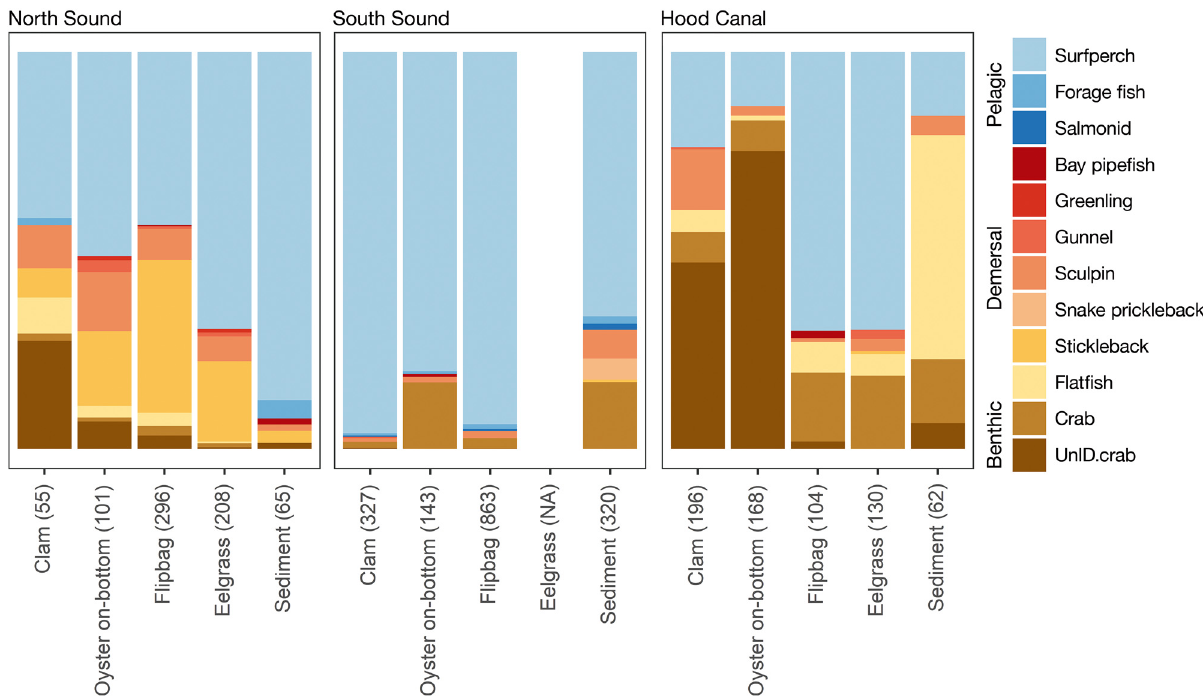
Fig. 3. Proportion of species groups observed in clam, oyster on-bottom, flipbag, eelgrass, and sediment mesohabitat types in North Sound, South Sound, and Hood Canal. Species are ordered by functional groups from top (pelagic: surfperch, forage fish, salmonid) to bottom (benthic: unidentified [UnID.] crabs and crabs), with demersal groups in the middle. The total number of fish and crabs observed is in parentheses after each label along the x